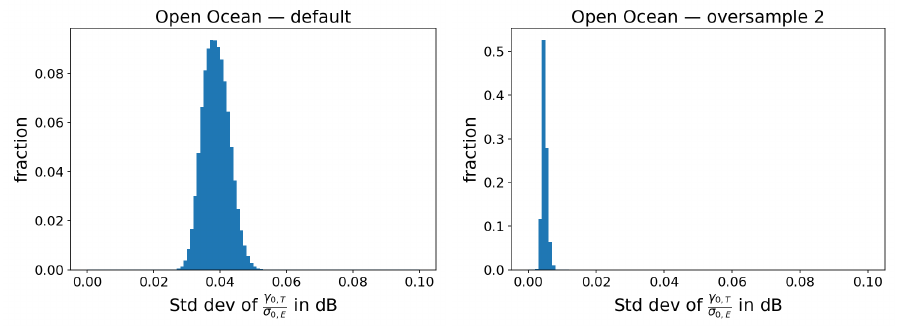
Figure 7. Histogram of the standard deviation of γ 0, T / σ 0, E for all pixels in the open-ocean burst off the California coast with default oversampling factor ( Left ) and an oversampling factor multiple of 2 ( Right ). The results from an oversampling factor of 2 match our simulations from Section